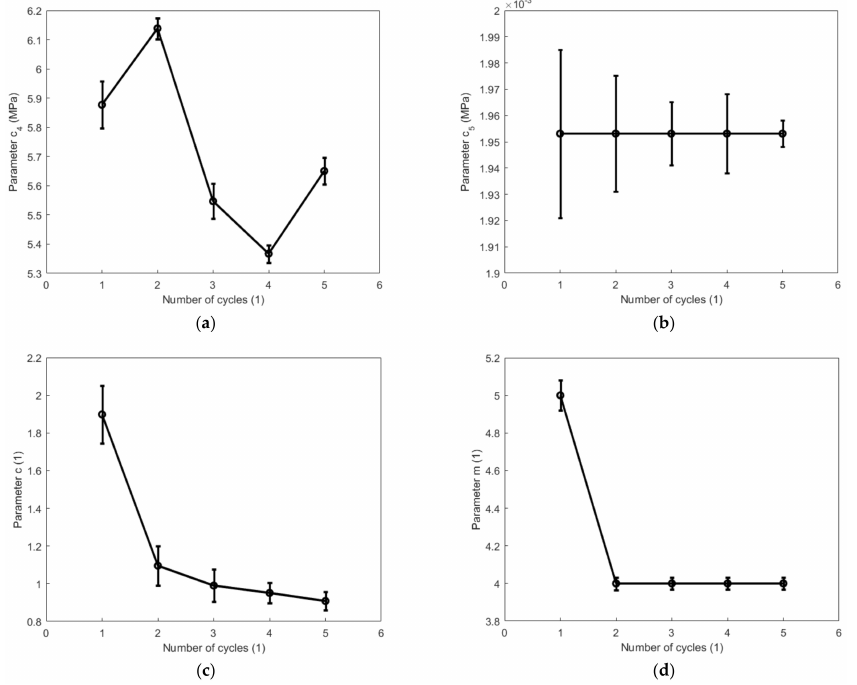
Figure 14. Evolutions of parameters c 4 , c 5 , c , and m with respect to the number of cycles during the cyclic compression process: ( a ) c 4 ; ( b ) c 5 ; ( c ) c , and ( d ) m